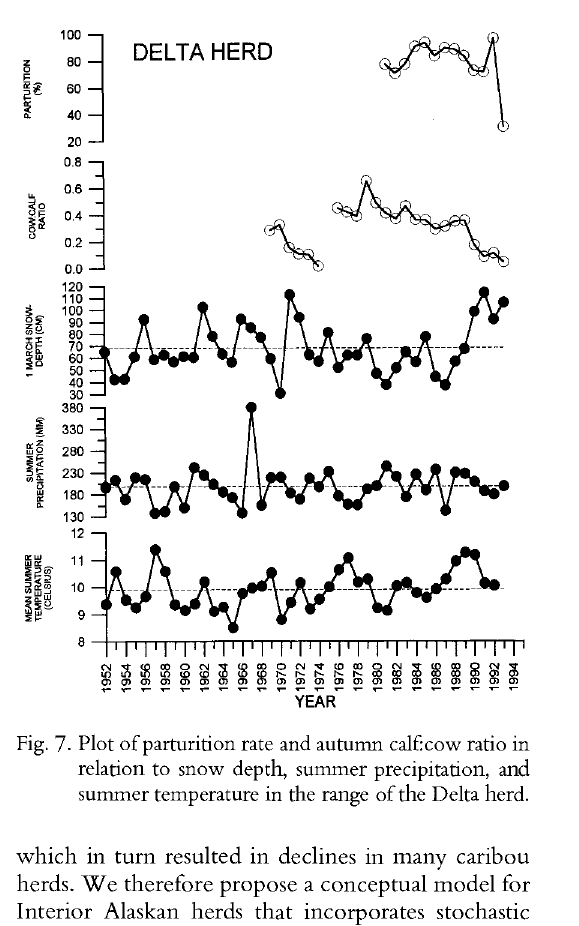
Fig. 7. Plot of parturition rate and autumn calfxow ratio in relation to snow depth, summer precipitation, and summer temperature in the range of the Delta